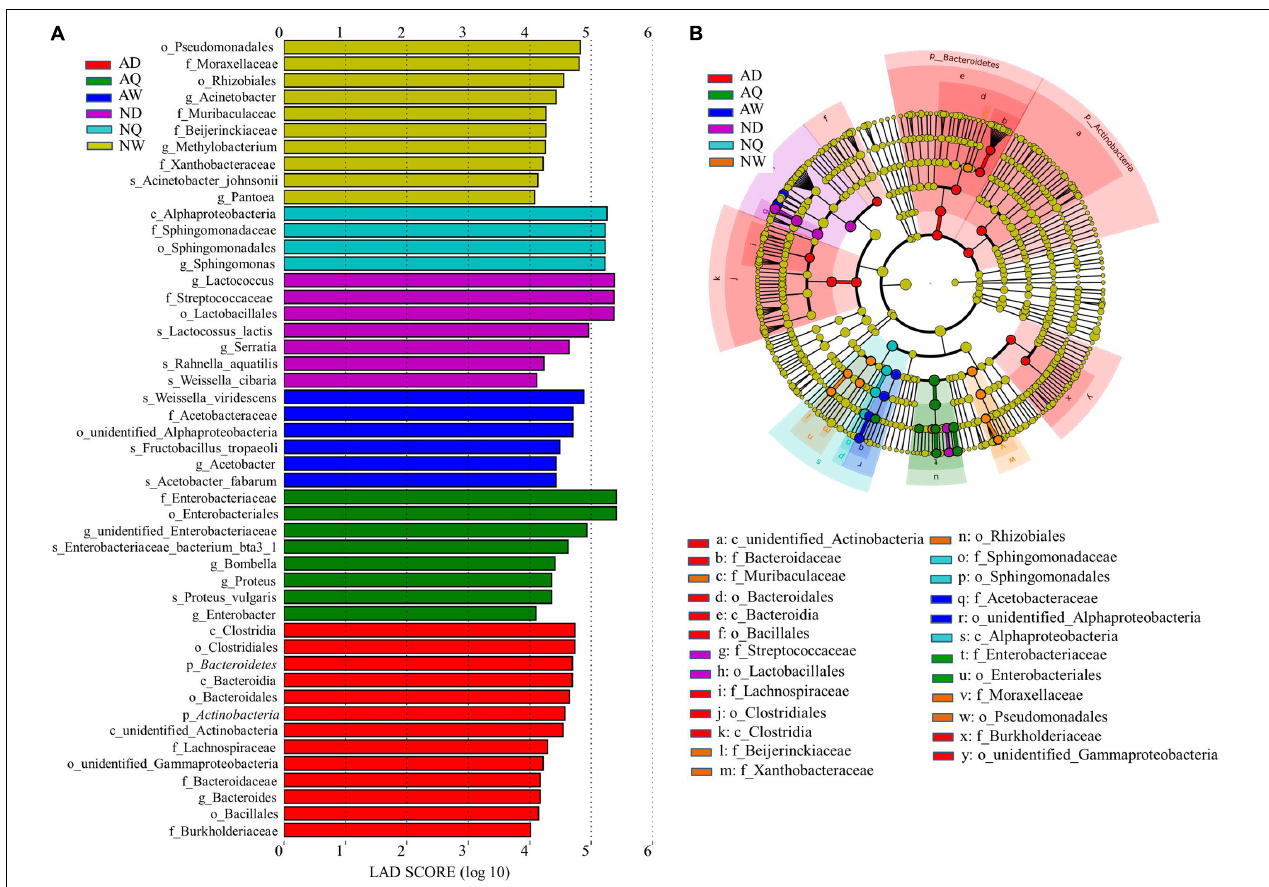
FIGURE 3 | Linear discriminant analysis effect size (LEfSe) analysis of microbial abundance among samples of Vespa velutina nigrithorax and Vespa velutina auraria . (A) Linear discriminant analysis (LDA) score identified the size of differentiation among samples of V. v. nigrithorax and V. v. auraria with a threshold value of 4.0. (B) The cladogram of microbial communities. AD, V. v. auraria males ; AQ, V. v. auraria queens ; AW, V. v. auraria workers; ND, V. v. nigrithorax males; NQ, V. v. nigrithorax queens; NW, V. v. nigrithorax